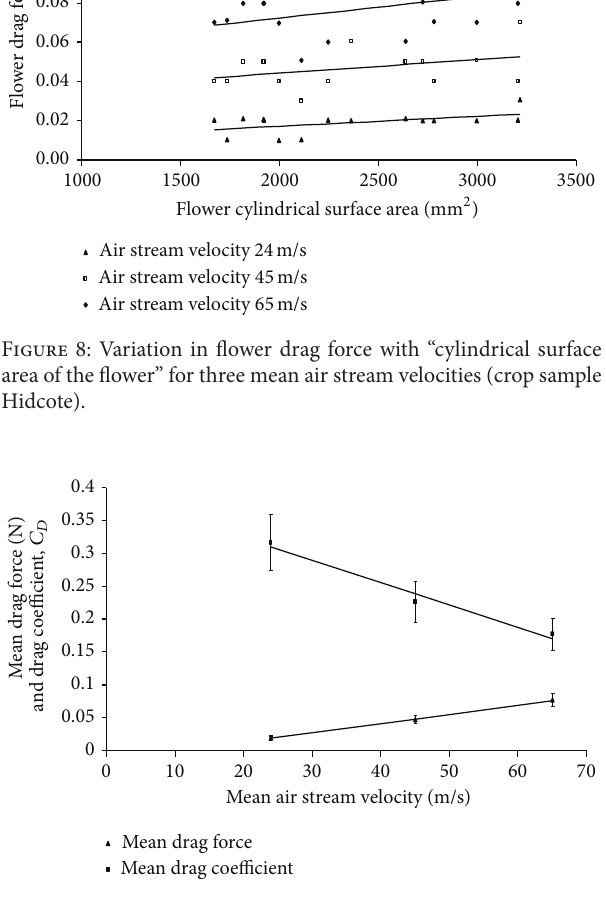
Figure 9: Variation in mean flower head drag force and drag coefficient with mean air stream velocity showing 95% confidence limits for mean